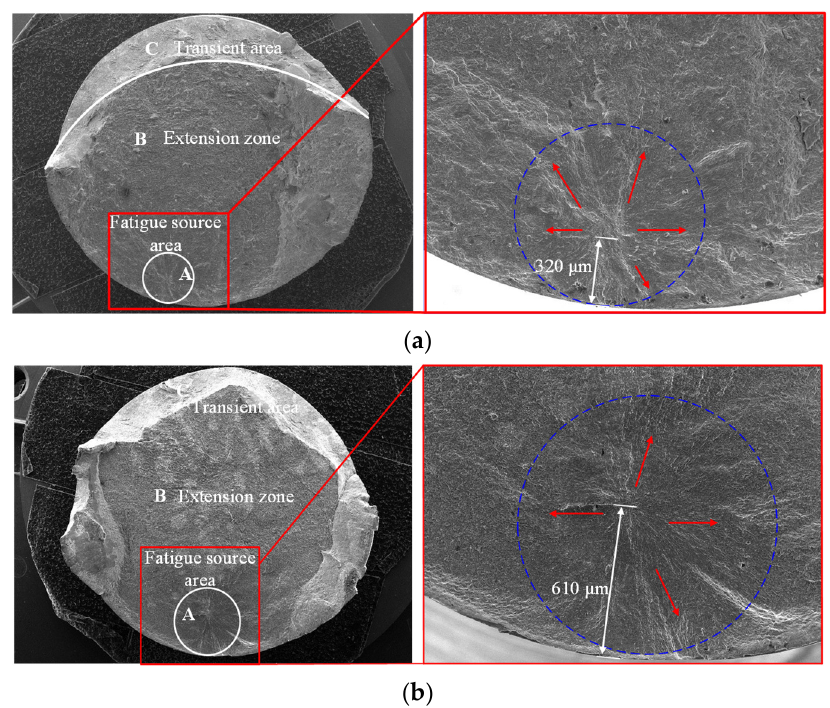
Figure 13. Fatigue fracture specimen. ( a ) Turned specimen; ( b ) Ultrasonic-impacted specimen.